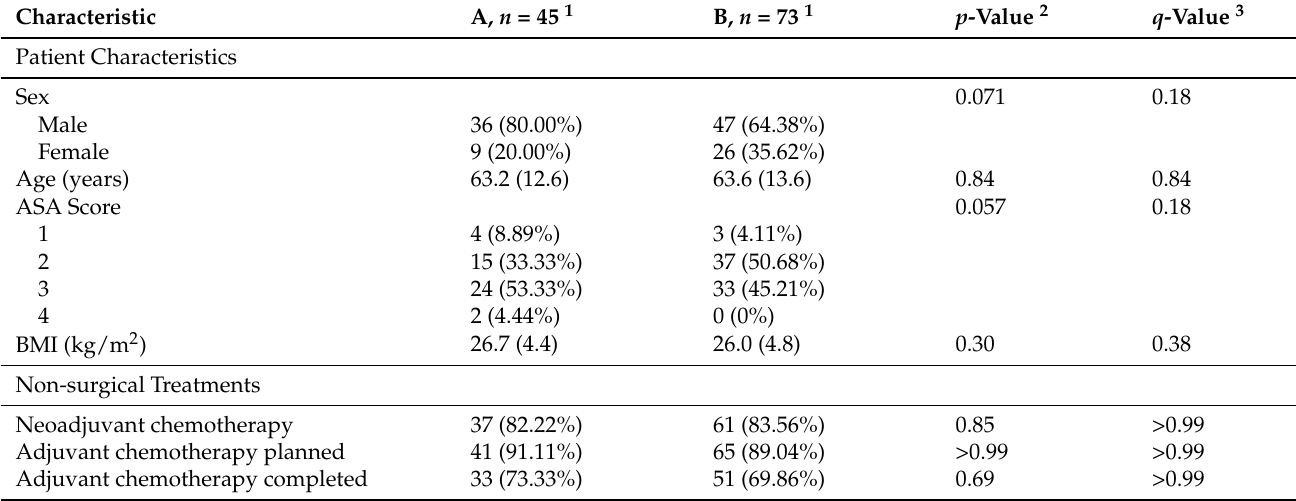
Table 1. Patient characteristics and perioperative